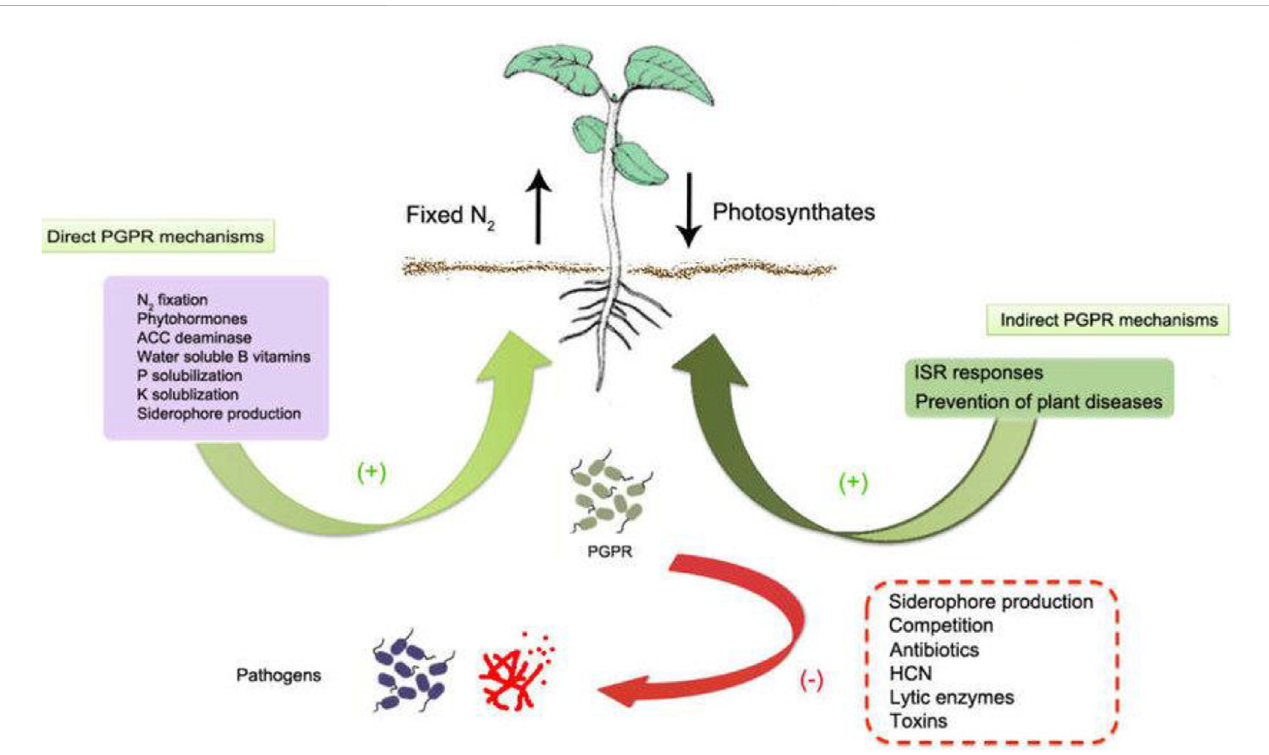
FIGURE 2 PGPR mechanism in the rhizosphere adopted from (Kamili et al., 2019; Nazir and Kamili, 2018).